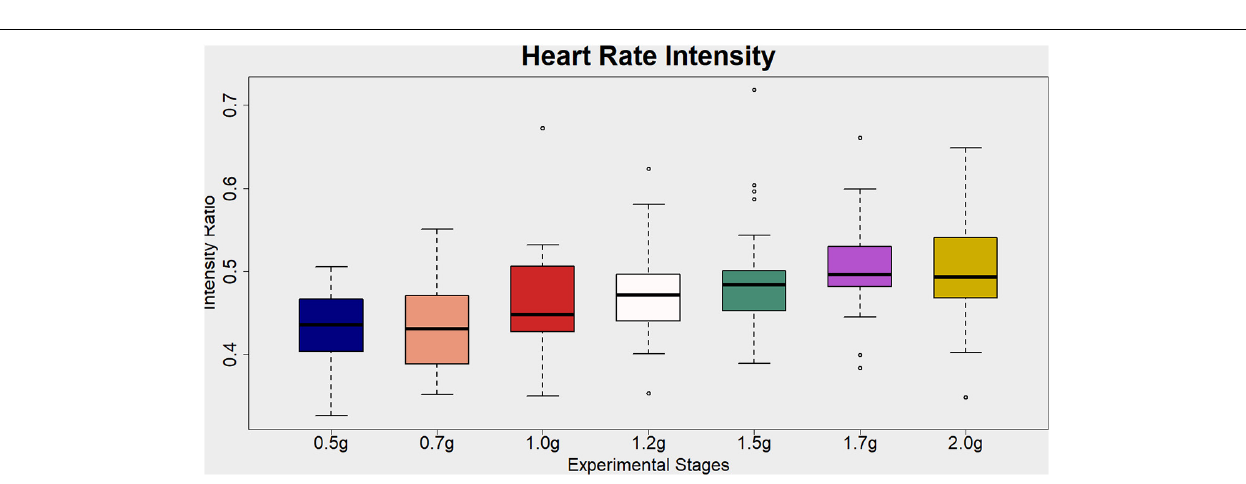
FIGURE 3 | Relative contribution (%) of the most significant HRV features between standing and all AG loads. The low frequency (LF) ranges is denoted with a blue bar (0.04–0.15 Hz), the high frequency (HF) is denoted with a green bar (0.15–0.40 Hz), and the very high frequency is denoted with a green bar ( > 0.40 Hz).